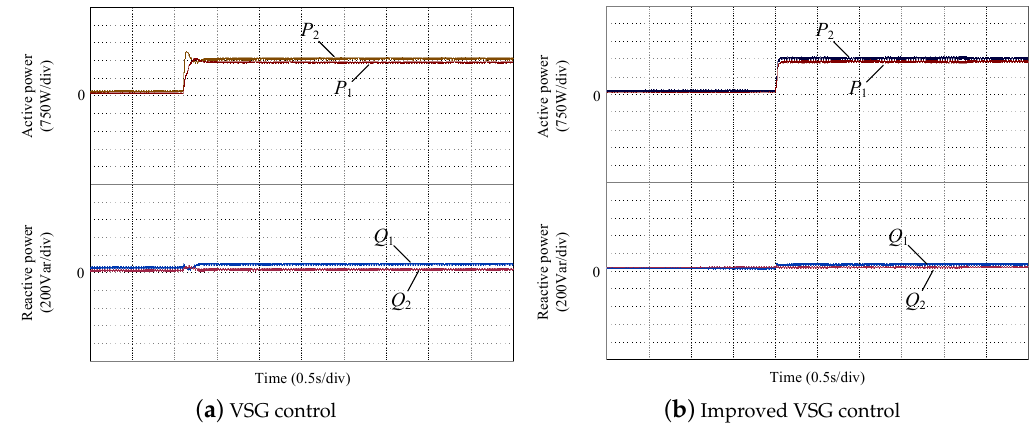
Figure 7. Power waveforms of parallel